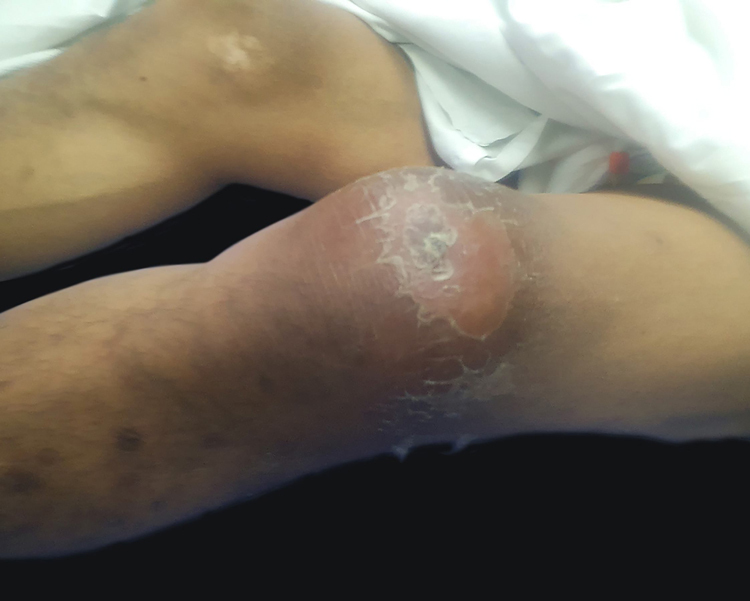
Reactive arthritis.